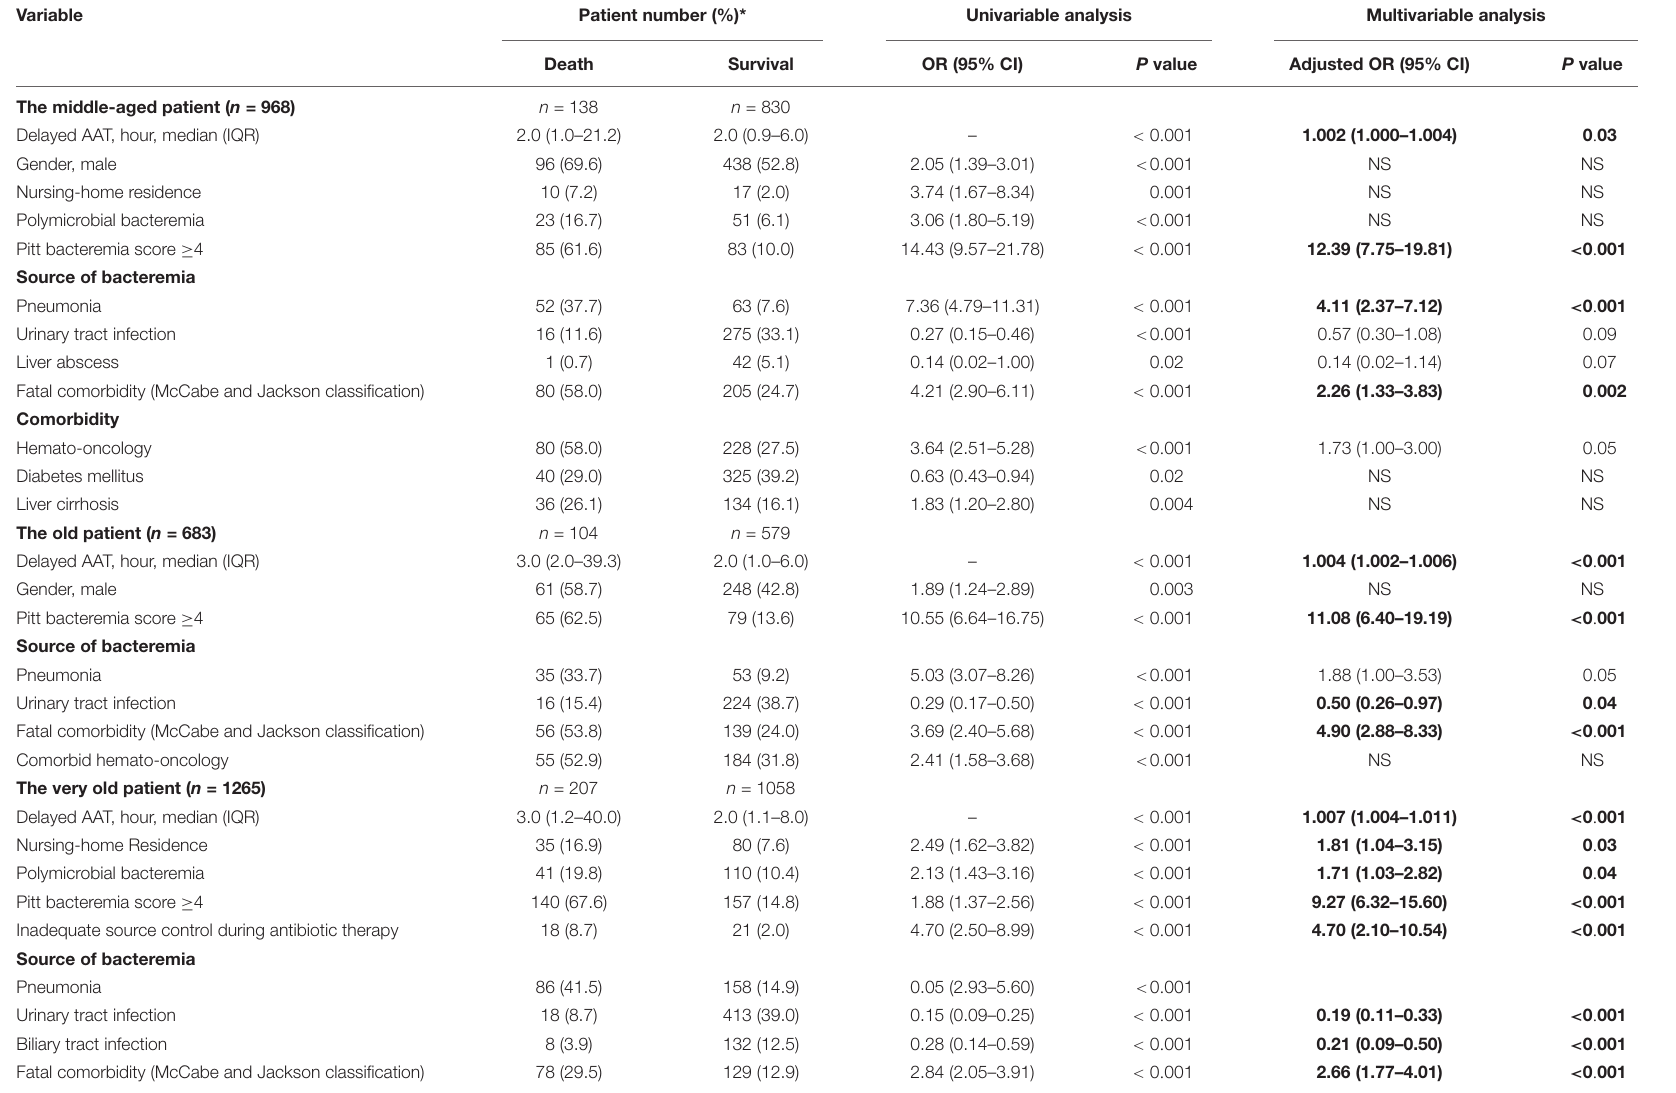
TABLE 2 | Prognostic impacts of hourly AAT delays in the middle-aged, old, and very old groups.